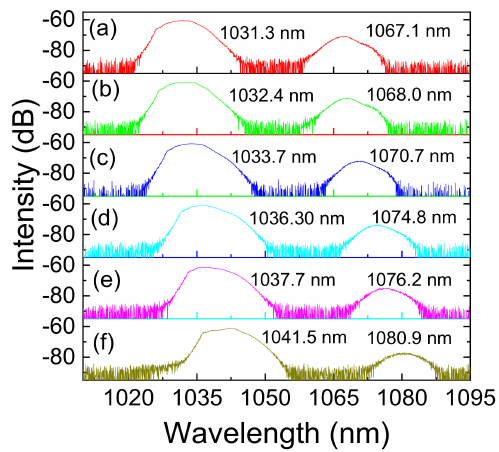
Figure 4. Tunable spectra of the dual-wavelength mode-locking operation by changing the polariza- tion state of the Sagnac loop. ( a ) The central wavelengths of the dual-wavelength mode-locked laser are 1031.3 nm and 1067.1 nm, respectively; ( b ) The central wavelengths are 1032.4 nm and 1068.0 nm, respectively; ( c ) The central wavelengths are 1033.7 nm and 1070.7 nm, respectively; ( d ) The central wavelengths are 1036.30 nm and 1074.8 nm, respectively; ( e ) The central wavelengths are 1037.7 nm and 1076.2 nm, respectively; ( f ) The central wavelengths are 1041.5 nm and 1080.9 nm,